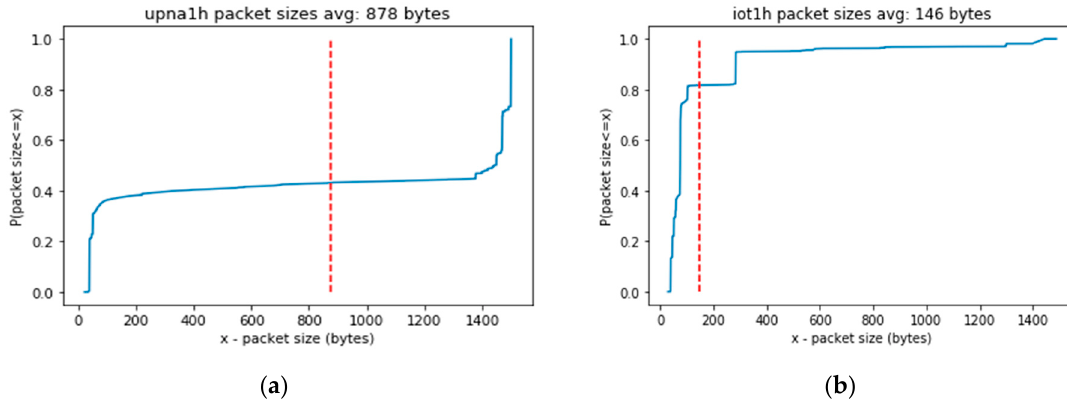
Figure 9. Cumulative distribution functions of packet sizes ( a ) in upna1h traffic trace, or ( b ) in iot1h traffic trace.